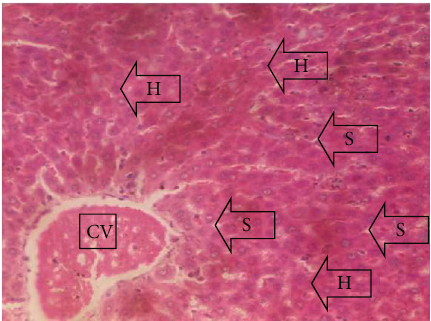
Figure 2: Photomicrographs of the group II rats showing distorted liver of periportal in fi ltration of in fl ammatory cells, patent portal vein (PV), hepatic artery (HA), and bile duct (BD), also with intact hepatocytes and sinusoids.